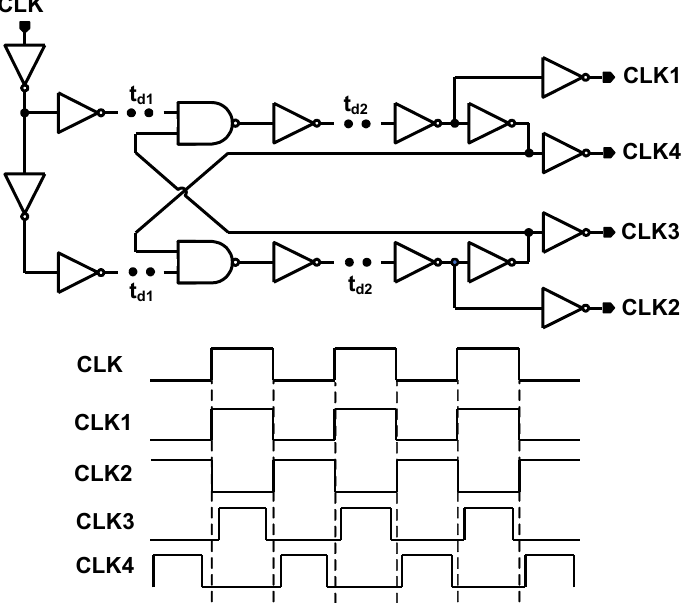
Figure 12. Non-overlap clock